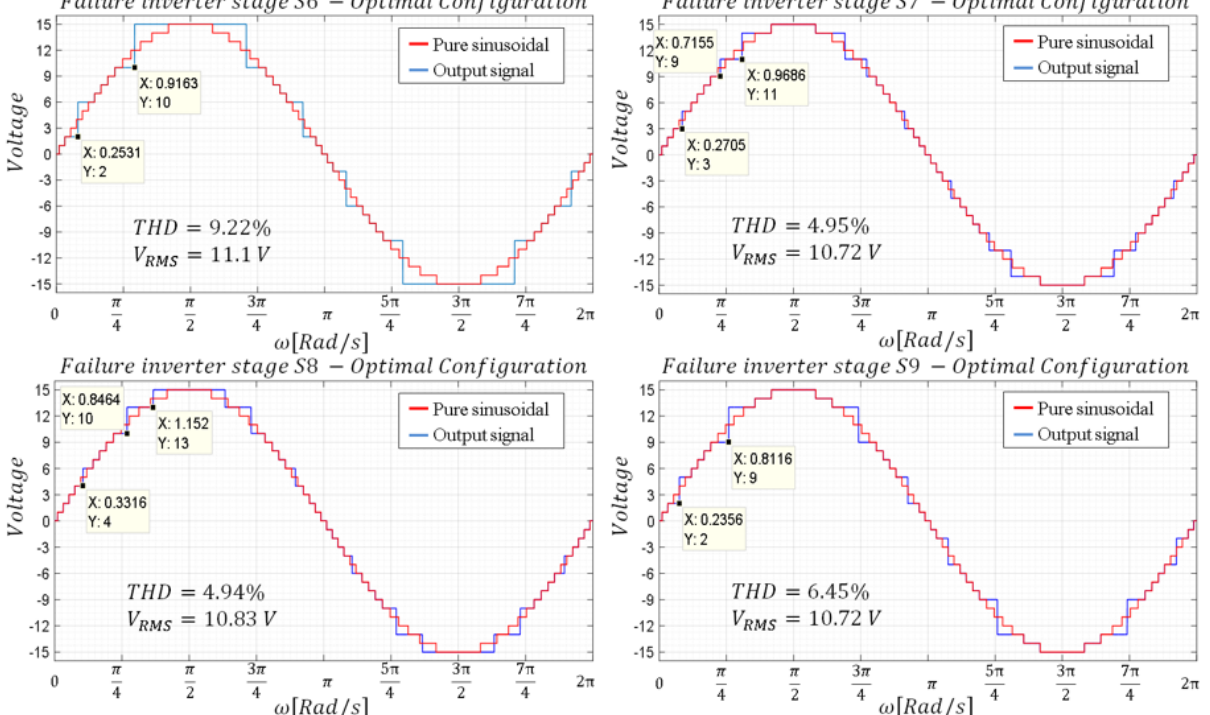
Figure 13. Waveforms—Base configuration with